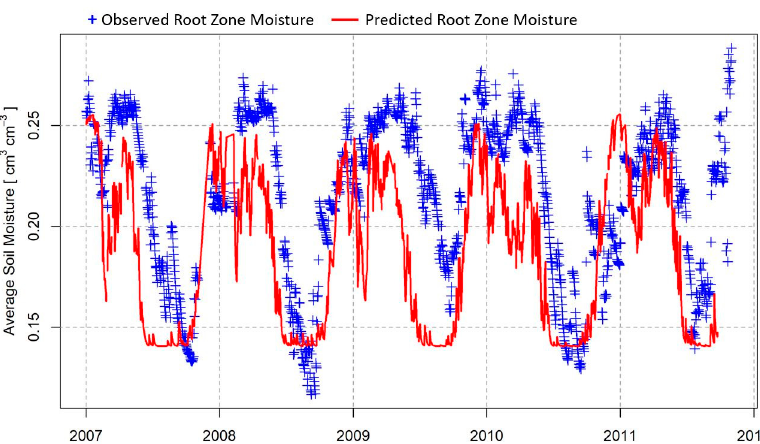
Figure 9. Time-series of average RZSM content (cm 3 cm − 3 ) at the Shale Hills from the five automatic soil moisture monitoring locations (blue crosses) and the regional SMAR model predictions, transformed to volumetric soil moisture content with CONUS root-zone porosity at the Shale Hills (red curve).